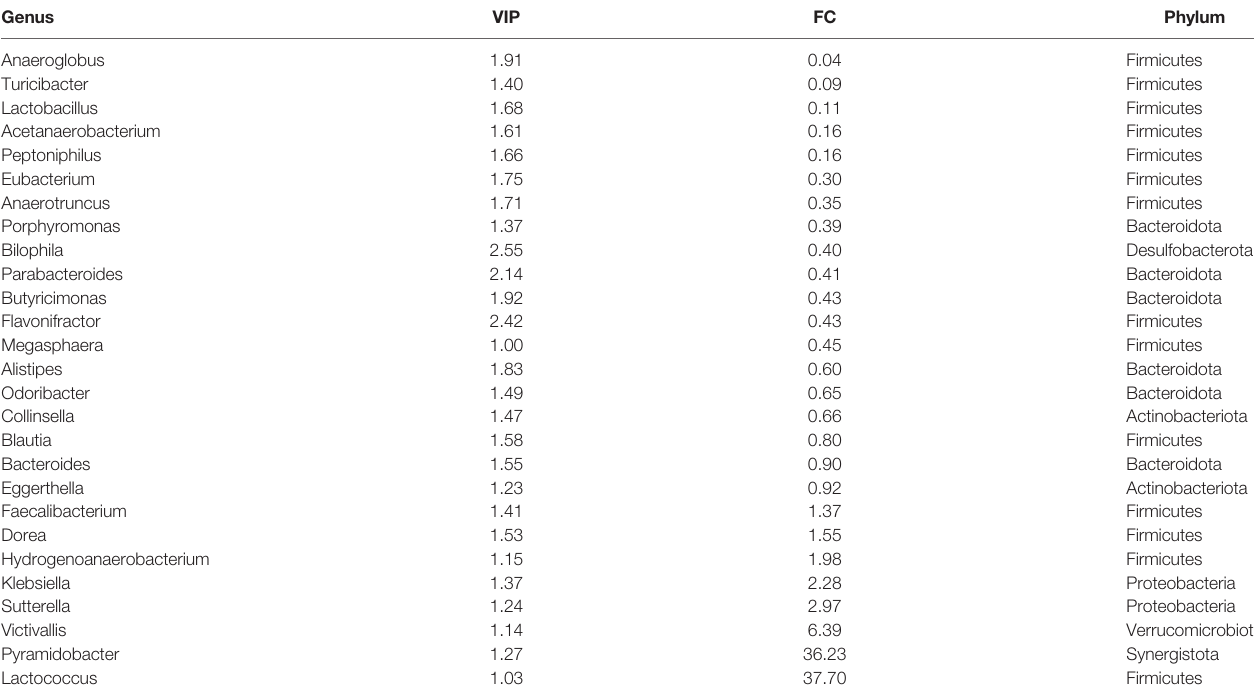
TABLE 3 | Differential genera responsible for discriminating severe MDD patients from